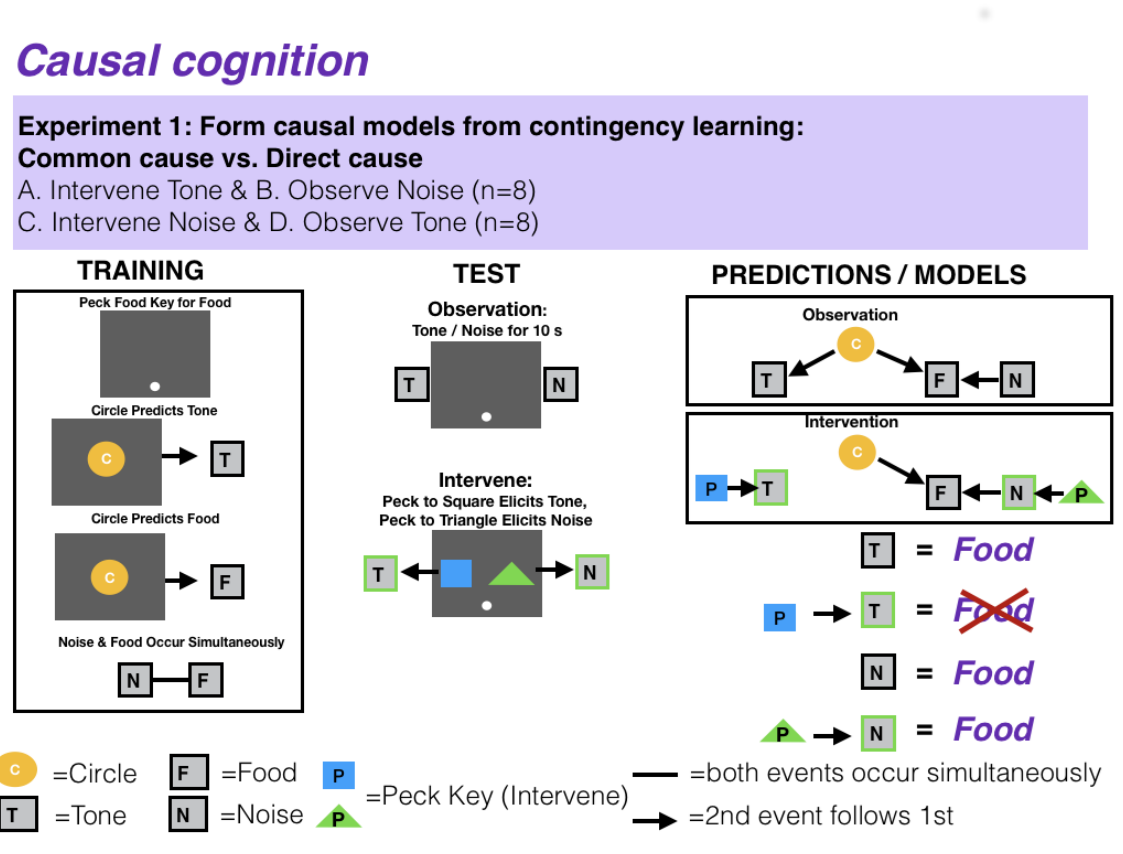
Figure 6. Planned design for experiment 1: Test figures adapted from Blaisdell et al. (2006). In